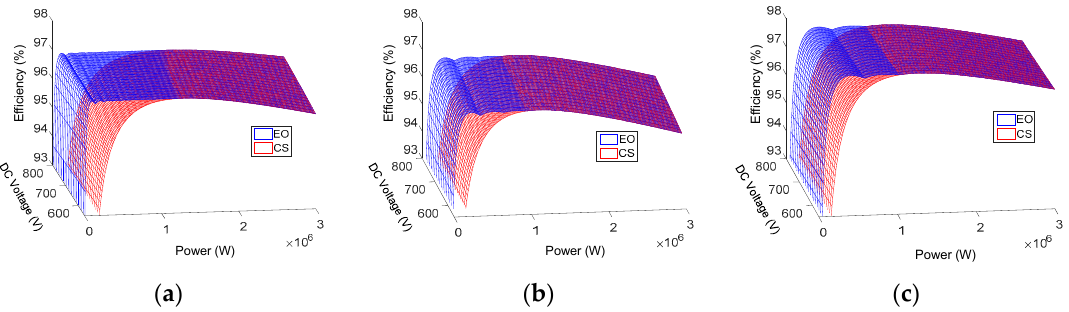
Figure 12. Efficiency surfaces with average current-sharing control method ( CS ) and efficiency- Figure 12. E ffi ciency surfaces with average current-sharing control method ( CS ) and e ffi ciency-oriented oriented method ( EO ). ( a ) Perfect Galaxy International Ltd EQX0250UV480TN. ( b ) Power-One method ( EO ). ( a ) Perfect Galaxy International Ltd. EQX0250UV480TN. ( b )